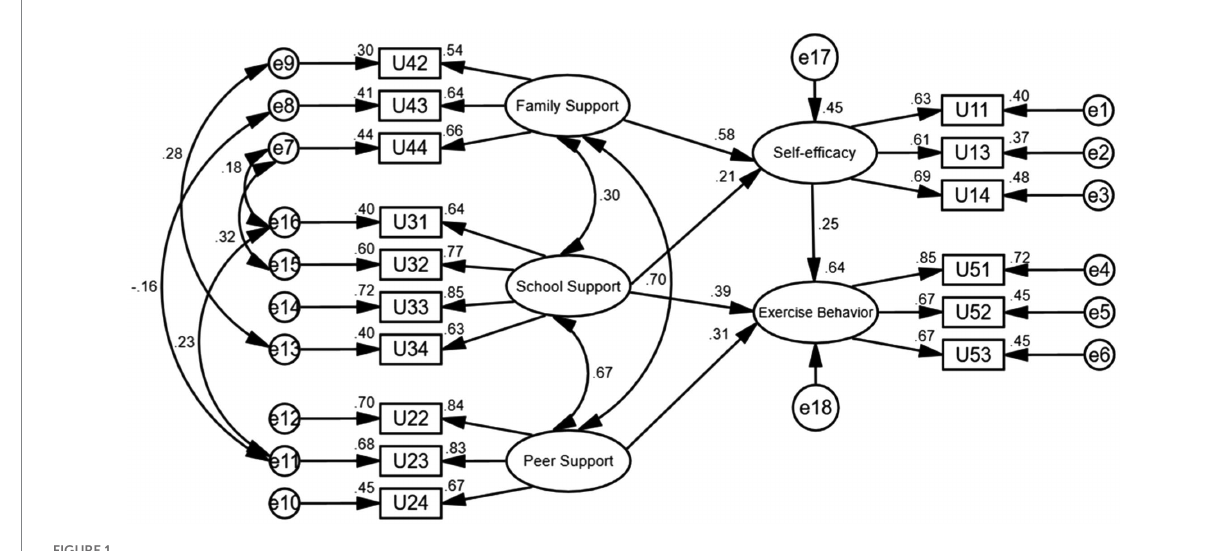
FIGURE 1 Path analysis of structural equation